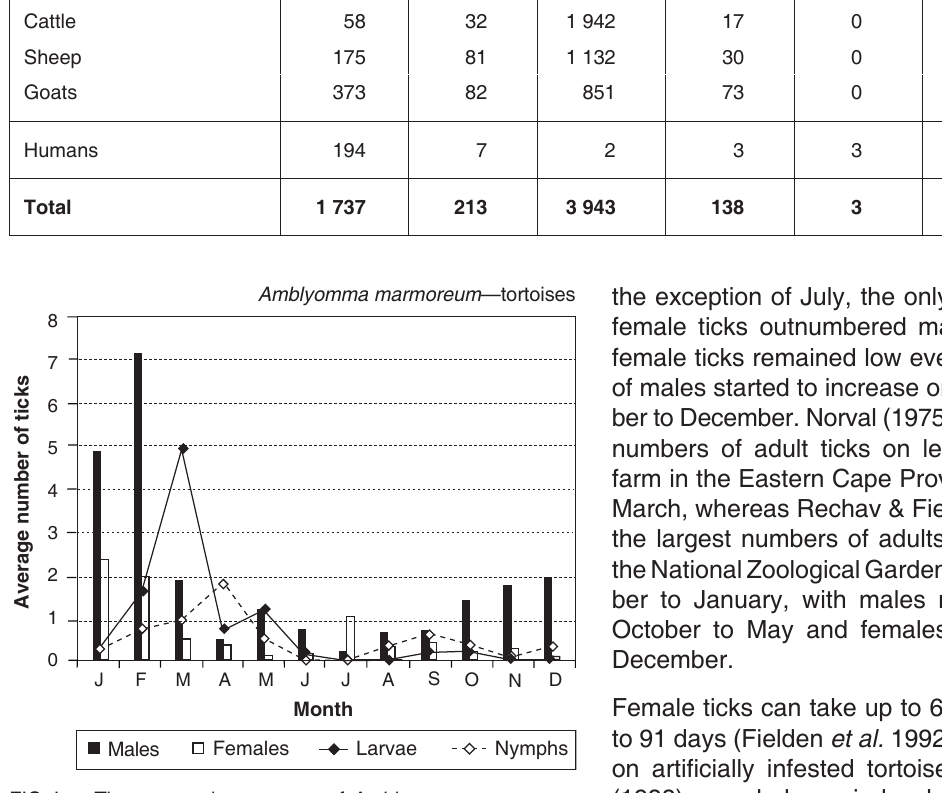
FIG. I The seasonal occurrence of Amblyomma marmoreum on tortoises in South